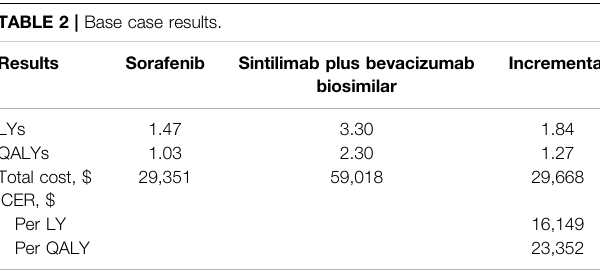
TABLE 2 | Base case